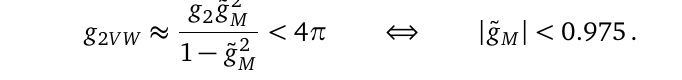
(cid:113) / . 1 − ˜ g 2 M M stem from g M 2